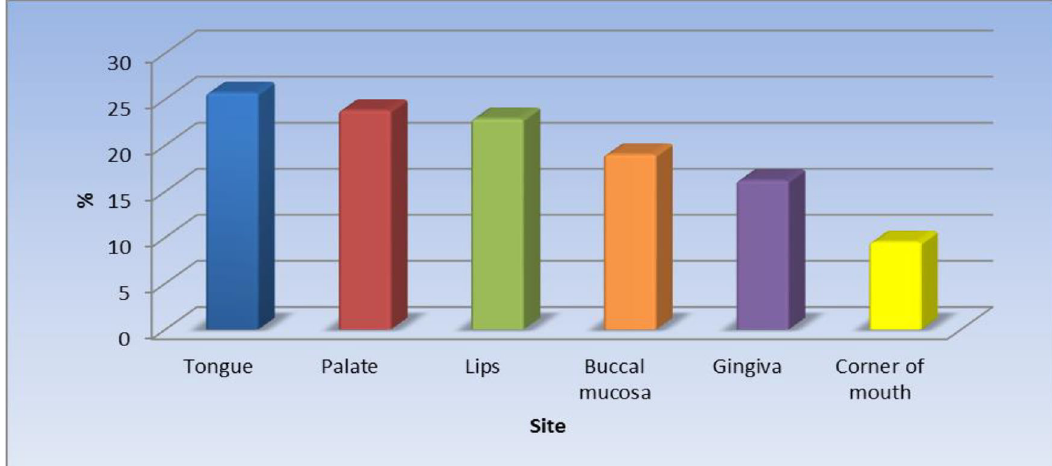
Figure 1. Clinical sites of the oral lesions (n = 105).